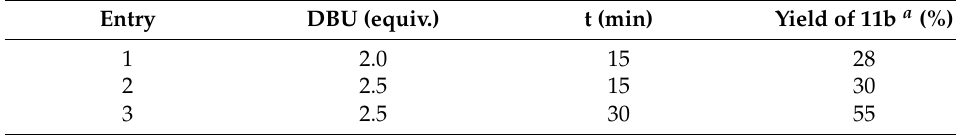
Table 2. Conditions for the one-pot synthesis of oxadiazole 11b